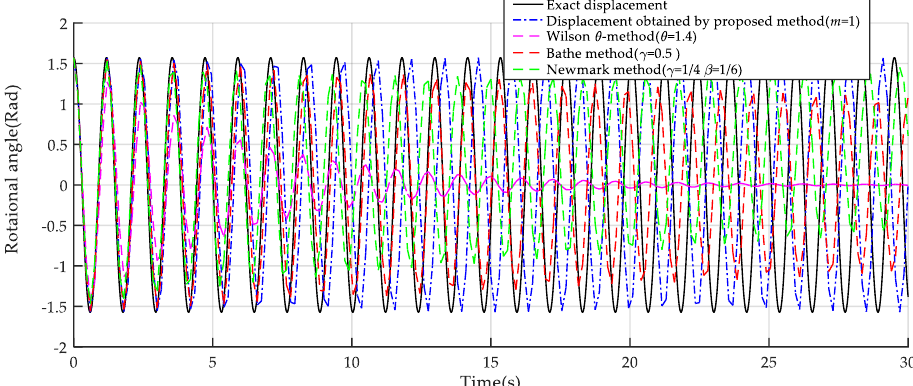
Figure 8. Comparisons of responses among the exact solution, Newmark method, Wilson method, Bathe method, and the present method with m = 1.